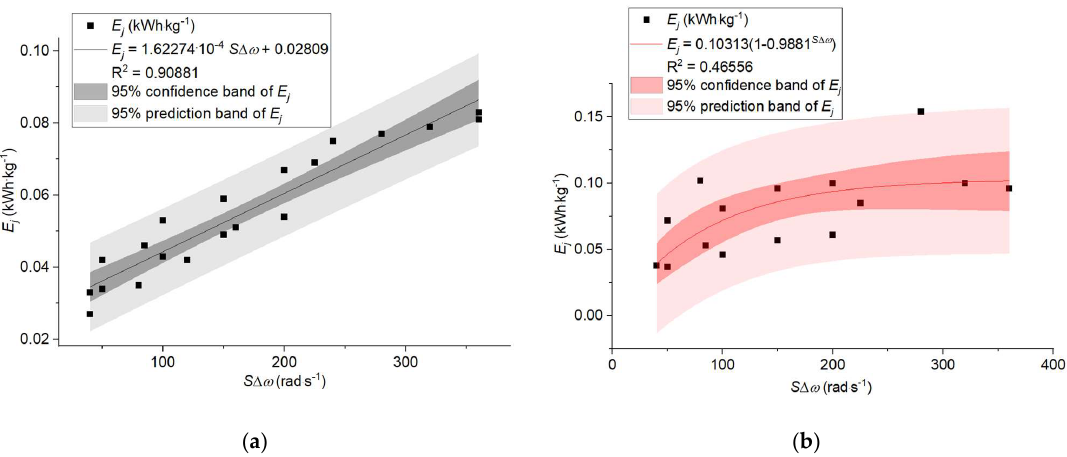
Figure 8. Unit energy consumption for grinding as a function of the total speed increase with indication of the confidence interval and predicted values for: ( a ) rice grain grinding and ( b ) corn grinding. Table 6. Test results of the significance of the coe ffi cients of the unit energy consumption regression model. - - Value Standard Error t -Value Prob > | t | Intercept 0.02809 0.00235 Rice